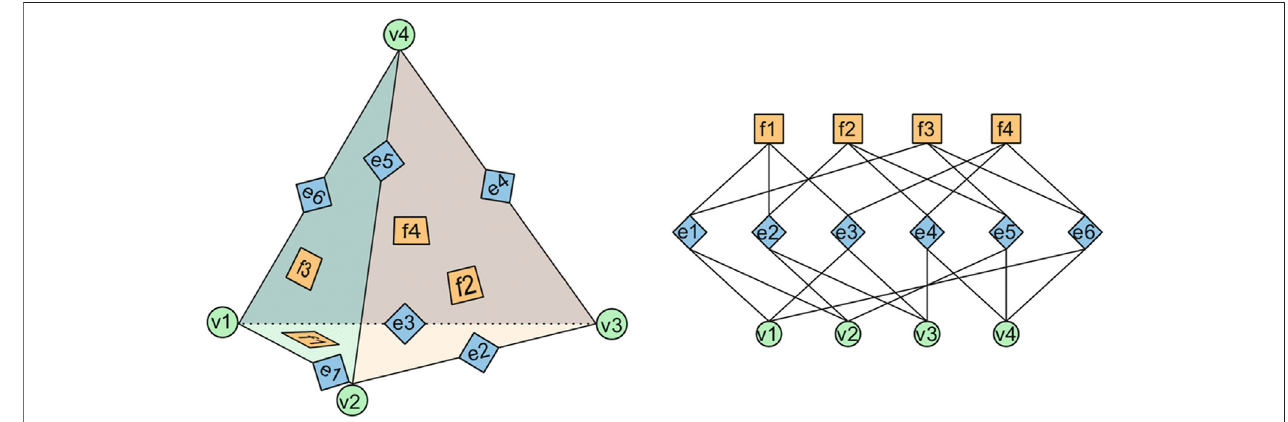
FIGURE 10 | A pyramid represented by a vertex-edge-face graph, illustrated geometrically (left) and topologically (right).